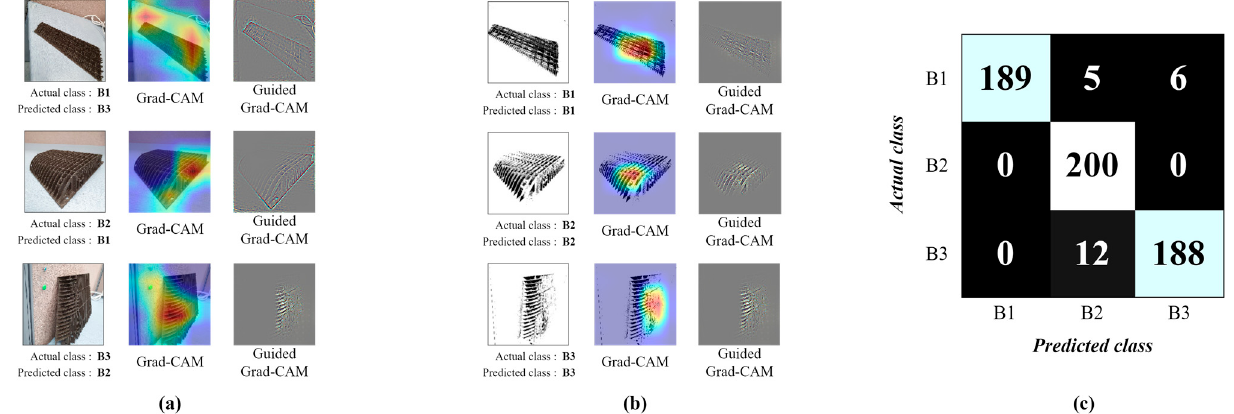
Figure 6. Grad-CAM and Guided Grad-CAM images for analyzing the causes of increased accuracy between Non-Thr densenet-201 2 and Thr 72 50 Resnet152V2 experimental environments: ( a ) Visualizing predicted result of Non-Thr densenet-201 2 experimental environment; ( b ) Visualizing predicted result of Thr 72 50 Resnet152V2 2 experimental environment. ( c ) Confusion matrix of Thr 72 50 Resnet152V2 2.